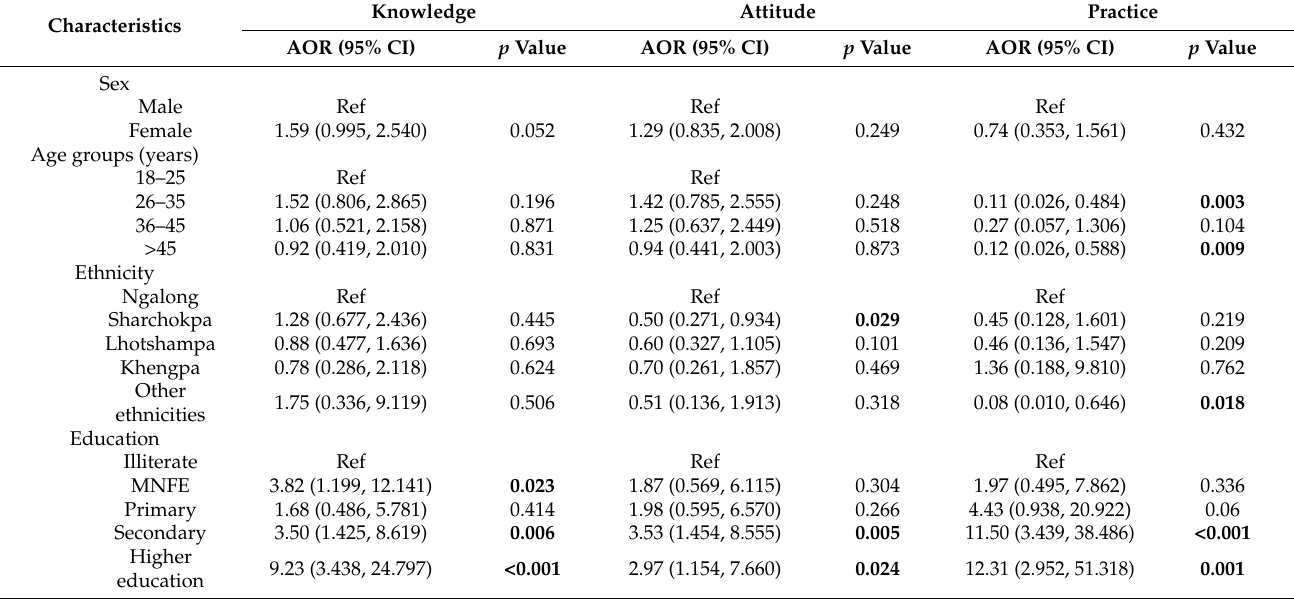
Table 4. Multiple logistic regression of knowledge, attitude, and practice scores among study participants in Phuentsholing Hospital,